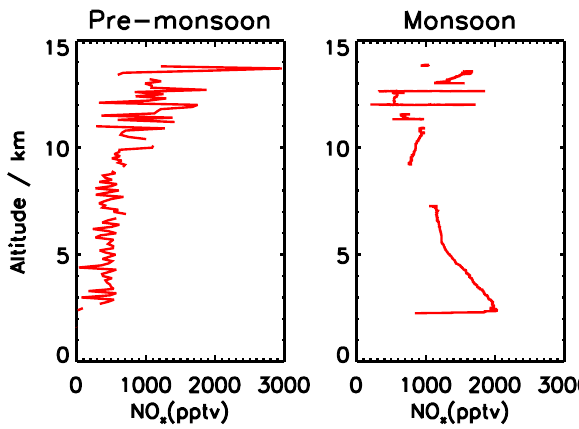
Fig. 7. Average NO x vertical profile of two Egrett flights during the pre-monsoon period (left) and NO x vertical profile for the flight on 22